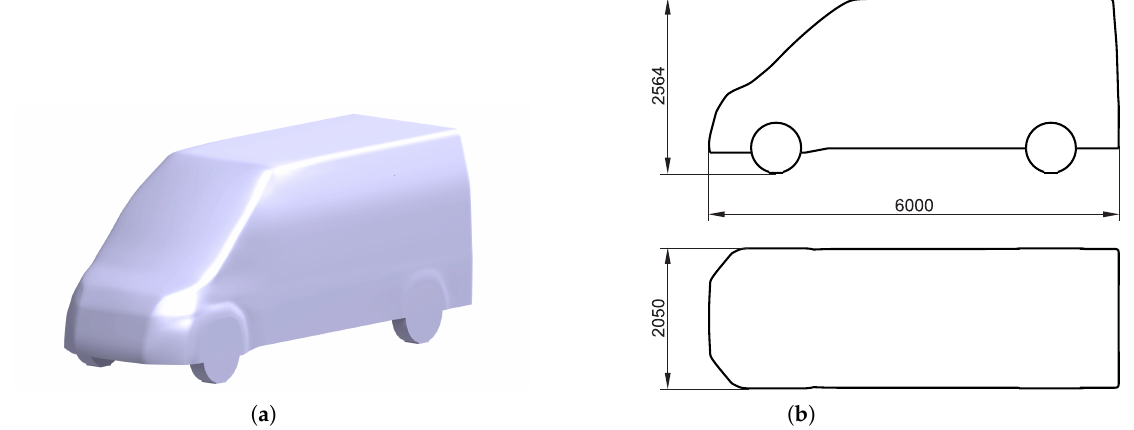
Figure 2. ( a ) Isometric view of the van model geometry ( b ) Nominal dimensions of the van model.